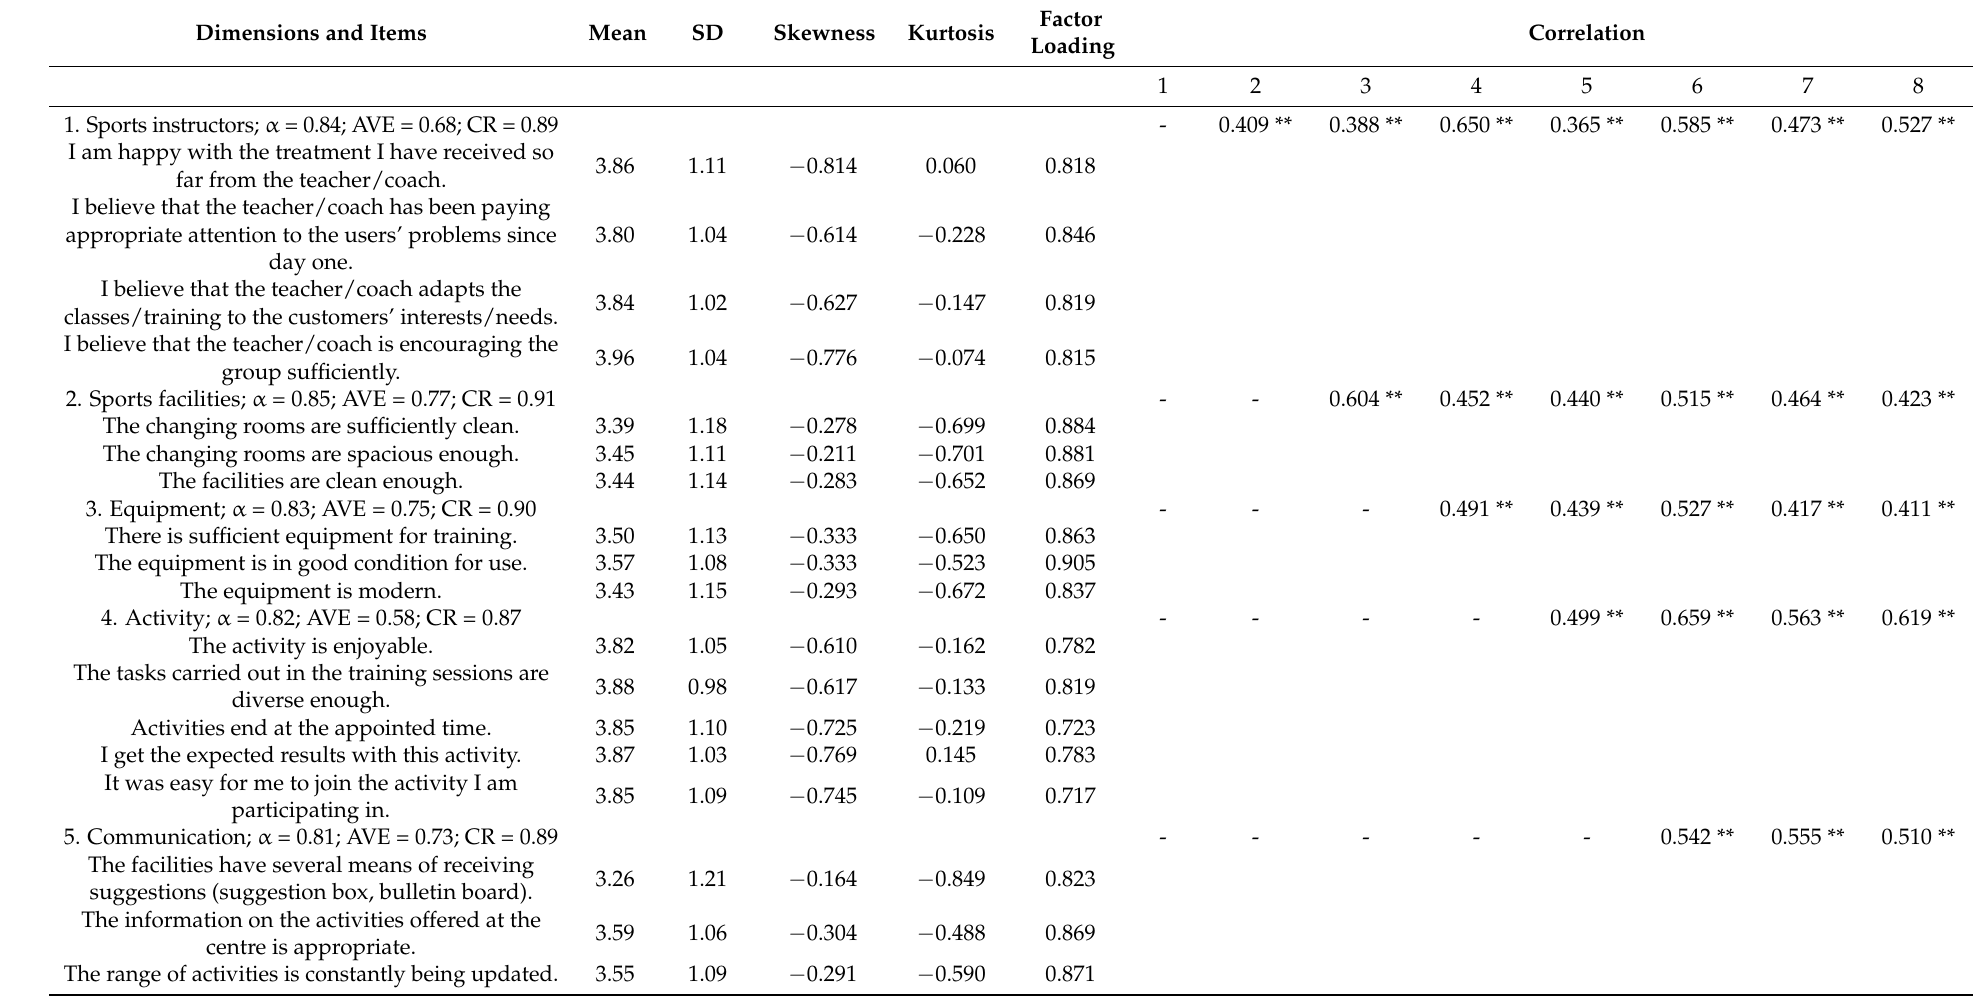
Table 1. Descriptive statistics, internal consistency, convergent and discriminant validity. Bivariate